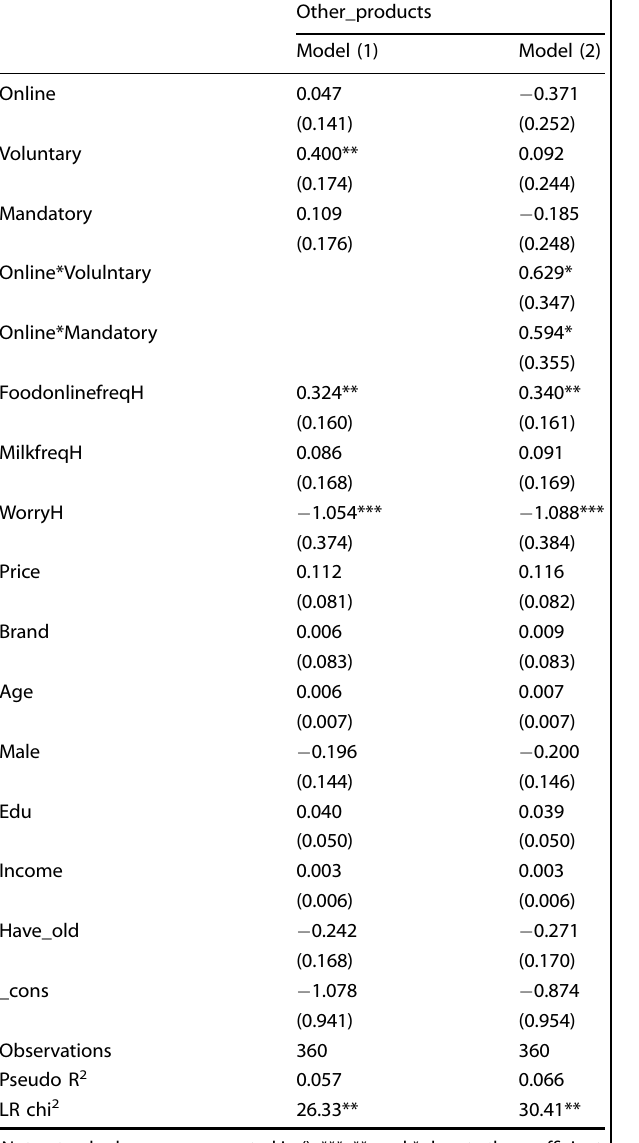
Table 3. Probit model results of whether purchasing other products of the same brand.